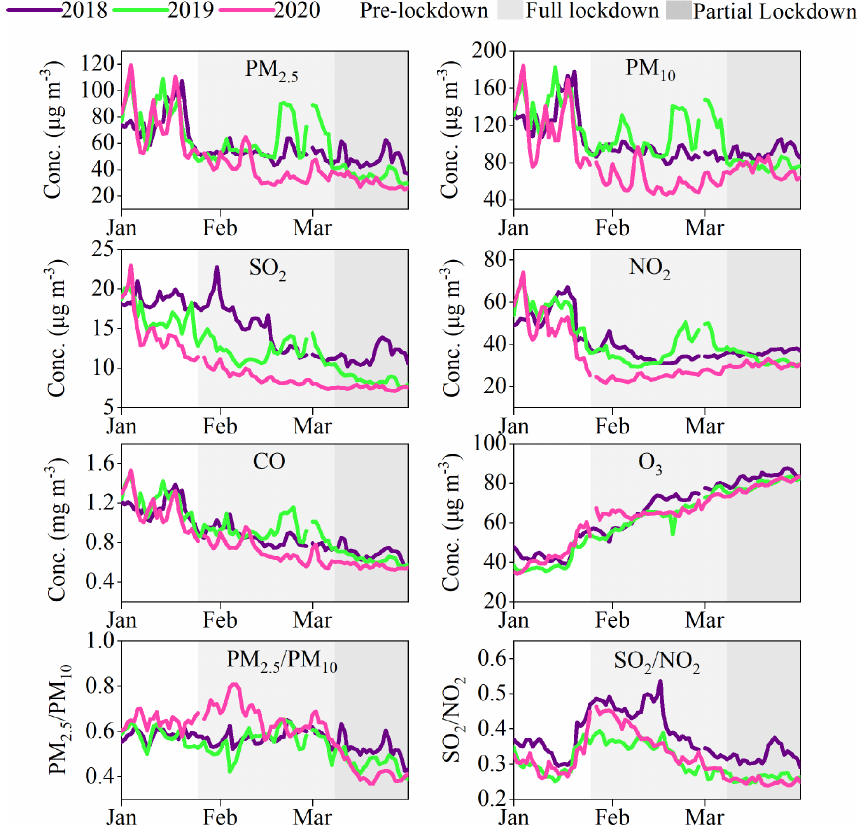
Figure 3. Time series of air pollutant concentrations and PM 2 . 5 / PM 10 and SO 2 / NO 2 during the different stages of COVID-19 lockdown start dates or equivalent in 2020 versus 2018 and 2019 based on the weather normalization